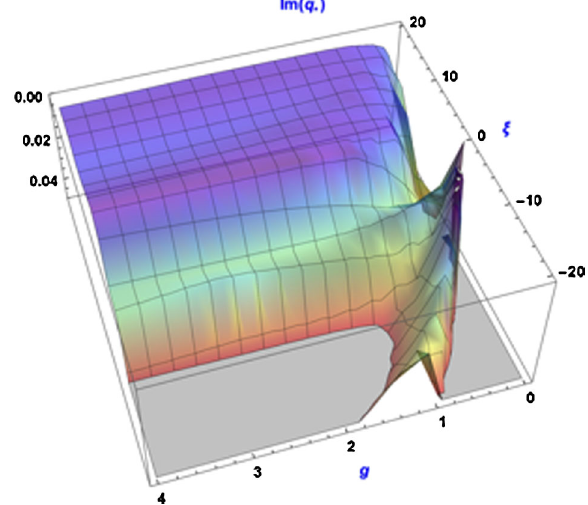
FIG. 25. Growth rate for a single bunch LHC beam and no feedback. The TMCI threshold is at ImpF ¼ 2 . 4 .